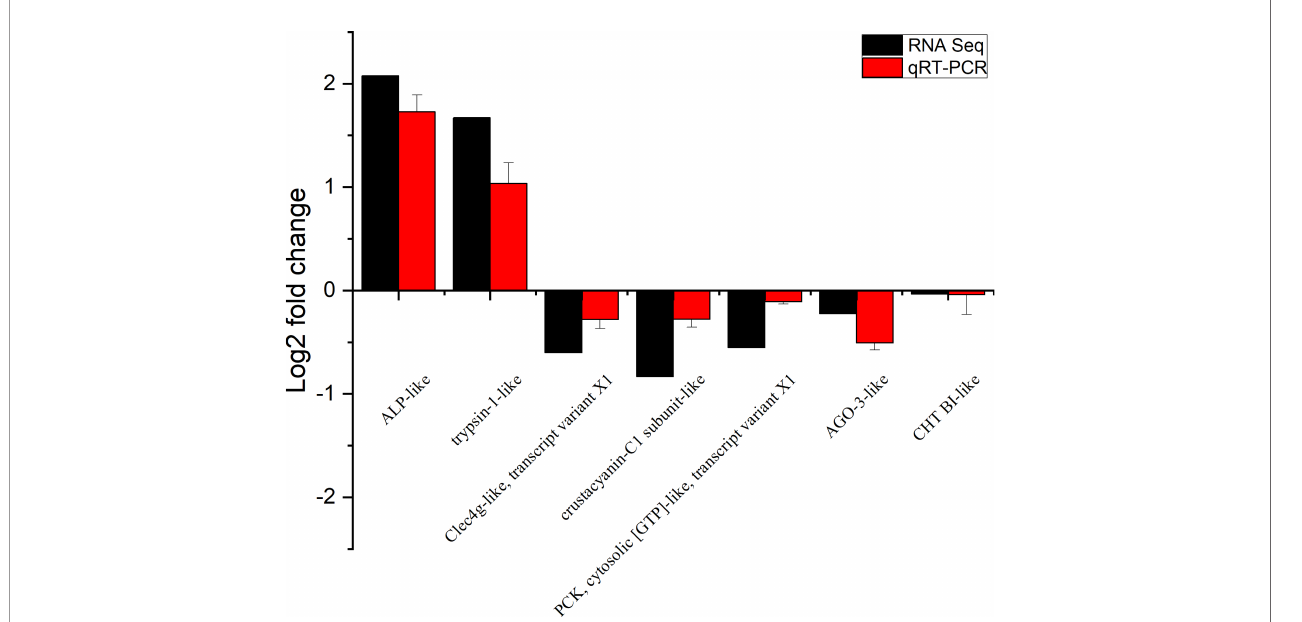
FIGURE 4 | Expression of seven differentially expressed genes (DEGs) in the transcriptome, veri fi ed by qRT-PCR. Beta-actin was used as an internal reference gene to standardize the data, and fold changes are shown to verify the RNA-seq results. ALP-like (alkaline phosphatase-like); Clec4g-like, transcript variant X1 (C-type lectin domain family 4 member G-like, transcript variant X1); PCK, cytosolic [GTP]-like, transcript variant X1 (phosphoenolpyruvate carboxykinase, cytosolic [GTP]- like, transcript variant X1); AGO-3-like (protein argonaute-3-like); CHT BI-like (chymotrypsin BI-like). Vertical bars represented the mean ± S.D. (n =